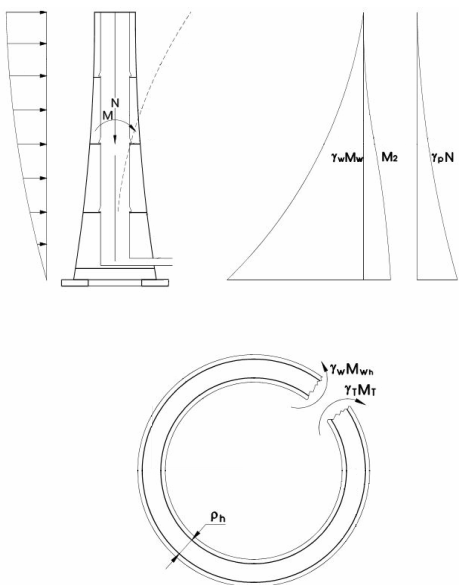
Figure 1. Design of concrete chimneys via two beam models (source: [2],